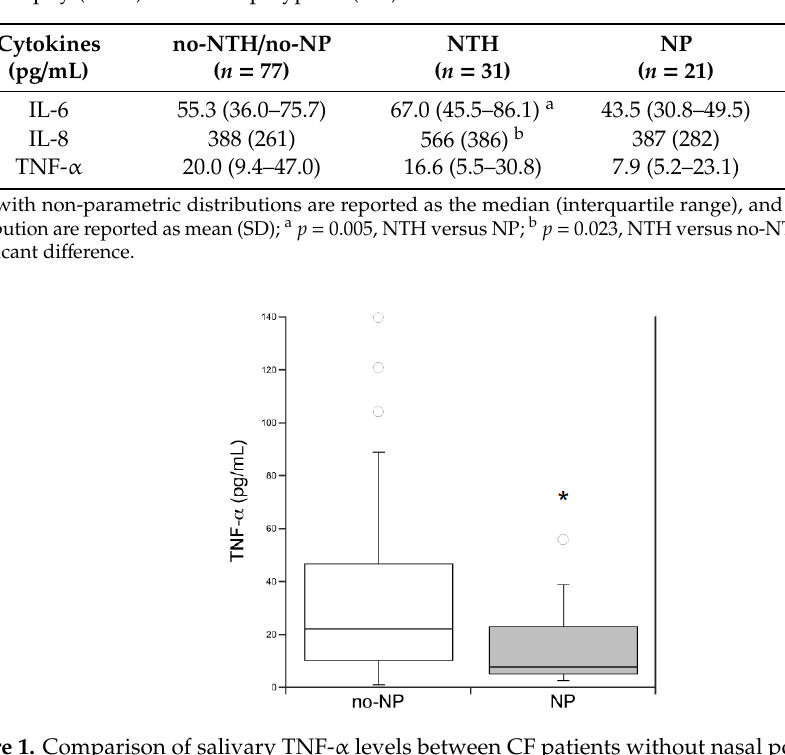
Table 4. Salivary IL-6, IL-8, and TNF- α levels in CF patients with and without inferior turbinate hypertrophy (NTH) and nasal polyposis (NP).